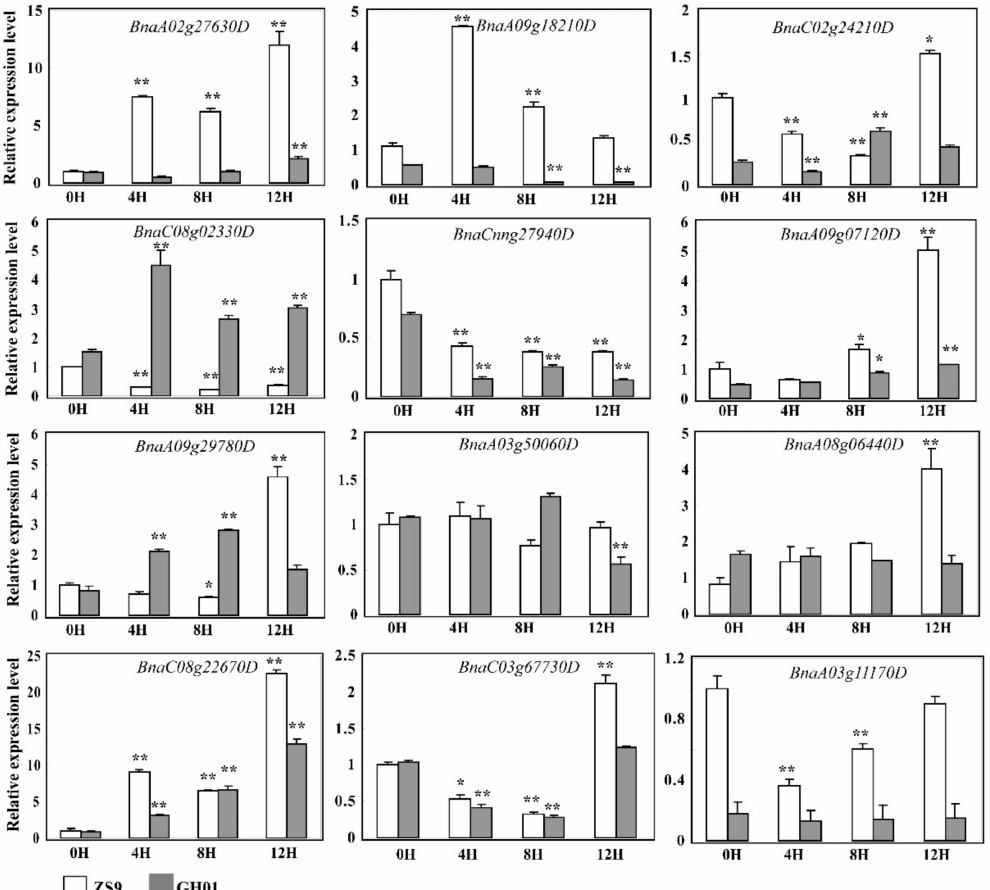
Figure 8. The relative expression level of candidate genes in ZS9 and GH01 germinated root before and after waterlogging stress by quantitative real-time polymerase chain reaction (qRT-PCR). Tissues used are indicated at the bottom. The values 0H, 4H, 8H, and 12H represent samples before waterlogging stress and after treatment for 4 h, 8 h, and 12 h, respectively. BnaACT7 and BnaUBC21 are amplified as internal reference. Asterisks indicate statistically significant differences between 0H and 4H, 8H, or 12H at ** p < 0.01 and * p < 0.05. Error bars indicate the standard errors based on three